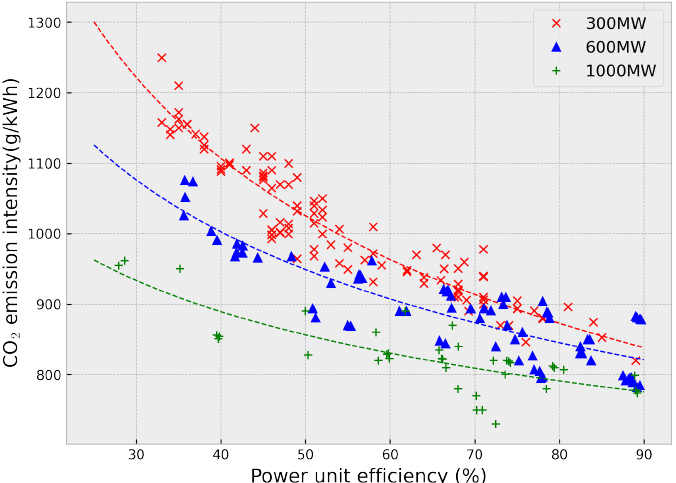
Figure 6. The relationship between CO 2 emission intensity and power unit generation